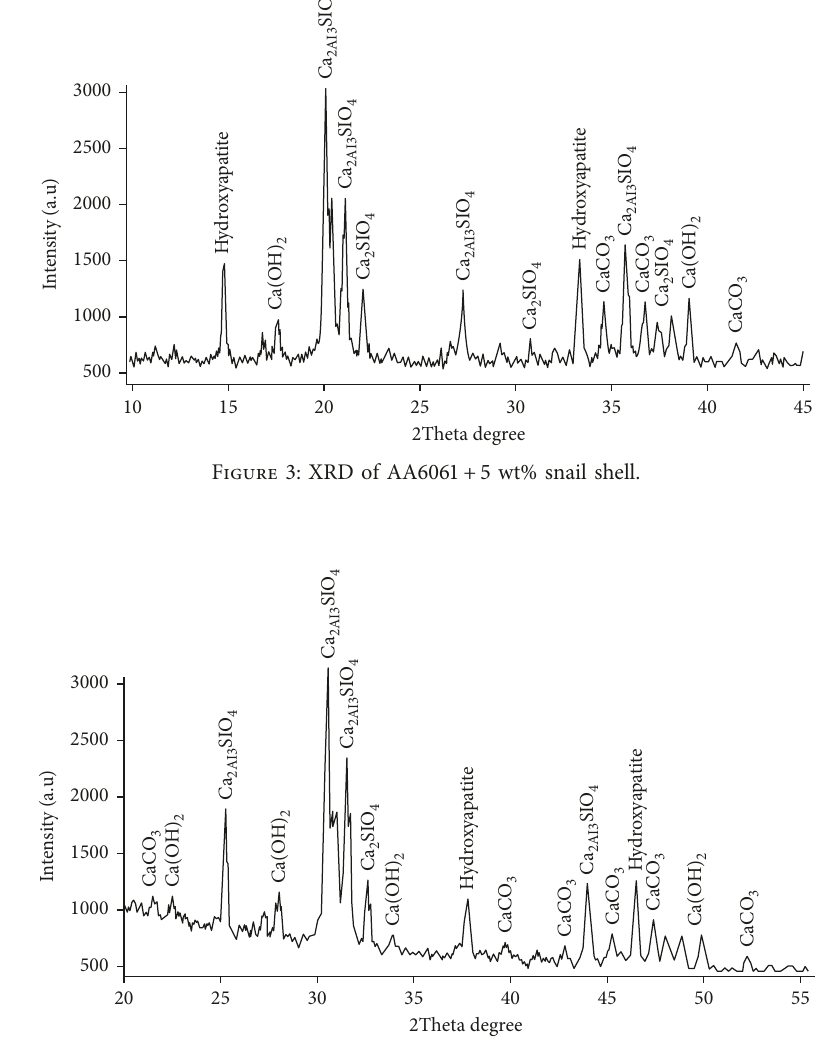
Figure 4: XRD of AA6061+10 wt% snail shell.